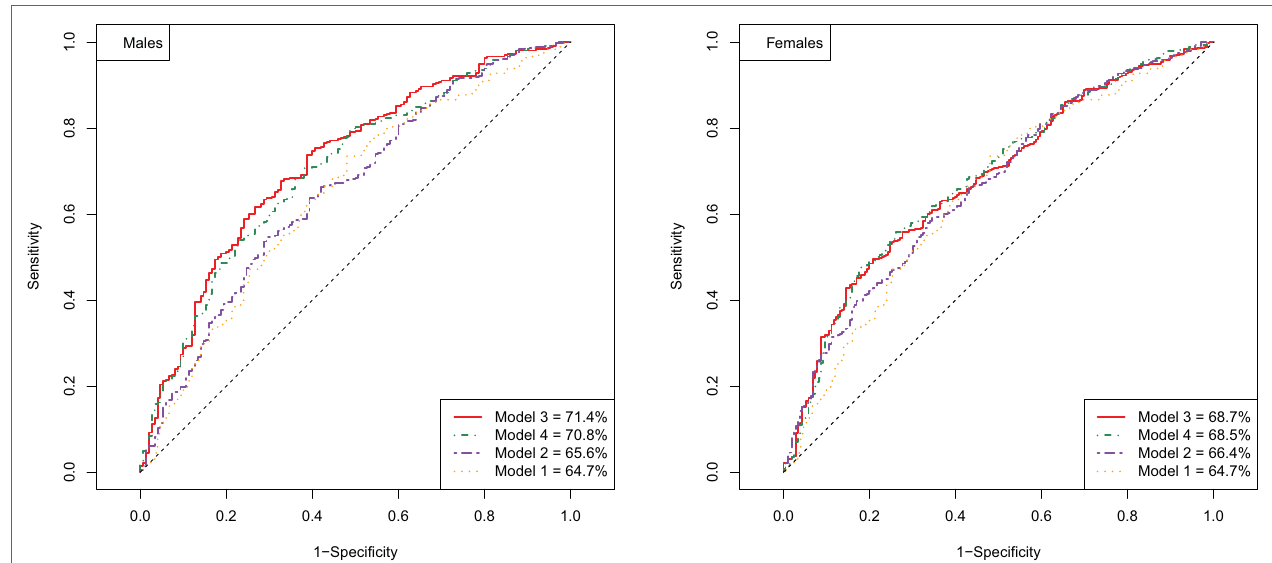
FigUre 1 | rOc curve of prediction models for longevity potential in males (left panel) and females (right panel) .